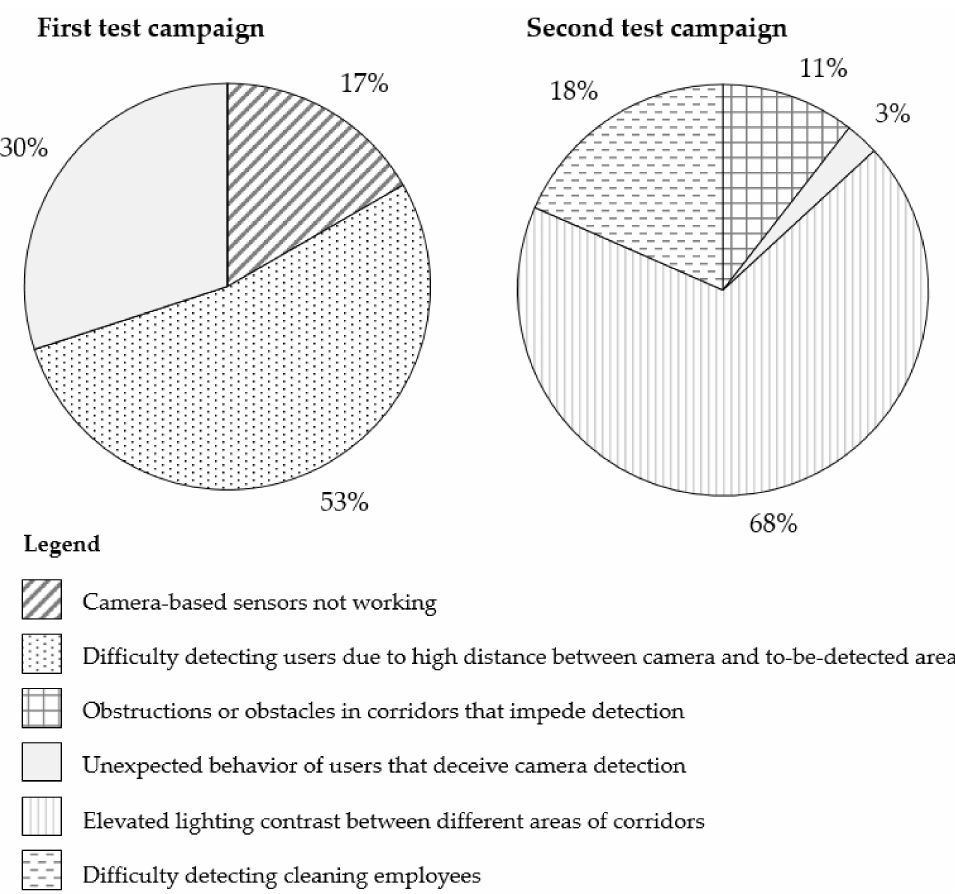
Figure 12. Charts of errors detected during first and second test